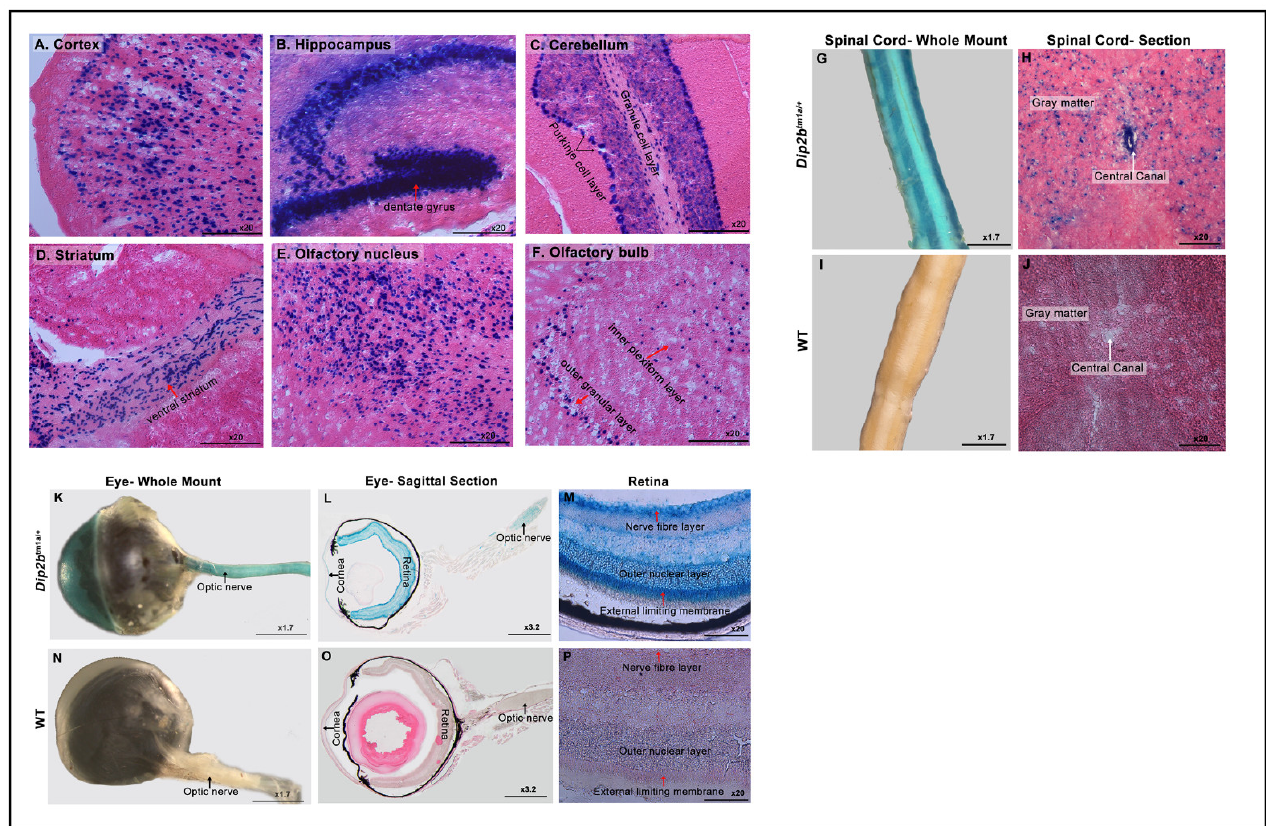
Figure 2. LacZ expression in the nervous system. ( A – F ) Frozen section expression analysis of Dip2b tm1a/+ brain regions at high magnification. ( A ) LacZ protein expression is notable in cortex neurons, ( B ) the hippocampus and dentate gyrus, ( C ) the granular and Purkinje cell layer of the cerebellum, ( D) the ventral striatum, ( E ) the olfactory nucleus, and ( F ) the inner plexiform and outer nucleus layer of the olfactory bulb in Dip2b tm1a/+ . ( G – J ) LacZ staining of the adult spinal cord. ( G ) Whole-mount staining of the adult spinal cord. ( H ) Longitudinal section of the spinal cord depicting LacZ signals in the gray matter and central canal in Dip2b tm1a/+ . ( I , J ) The wild-type whole-mounted and frozen sections were LacZ-negative. ( K – P ) LacZ staining in the adult eye. ( K ) Whole-mount staining of P56 mouse eyes, along with nerve fibers, showed LacZ staining. ( L ) Sagittal section of the eye stained for LacZ expression. The retinal wall and cornea showed LacZ expression in Dip2b tm1a/+ . ( M ) LacZ-positive retina of Dip2b tm1a/+ at high magnification showed strong signals in the external limiting membrane, outer nuclear layer, and optic nerve fiber layer. ( N – P ) Wild-type control was devoid of a LacZ-positive signal.